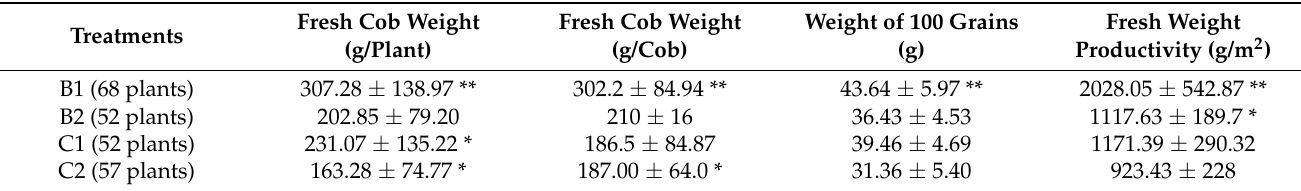
Table 4. Cob production and weight data based on treatment. Data are represented as mean ± standard deviation. Control: plots without biochar; B1: plots supplemented with biochar B1; B2: plots supplemented with biochar B2.